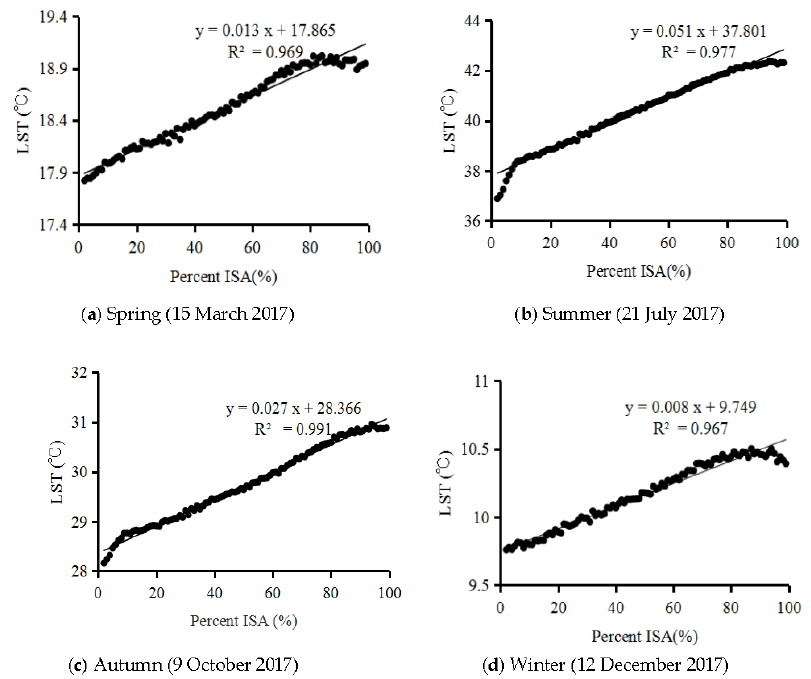
Figure 4. Scatter plots of the LST and percent ISA in the study area in the four seasons.